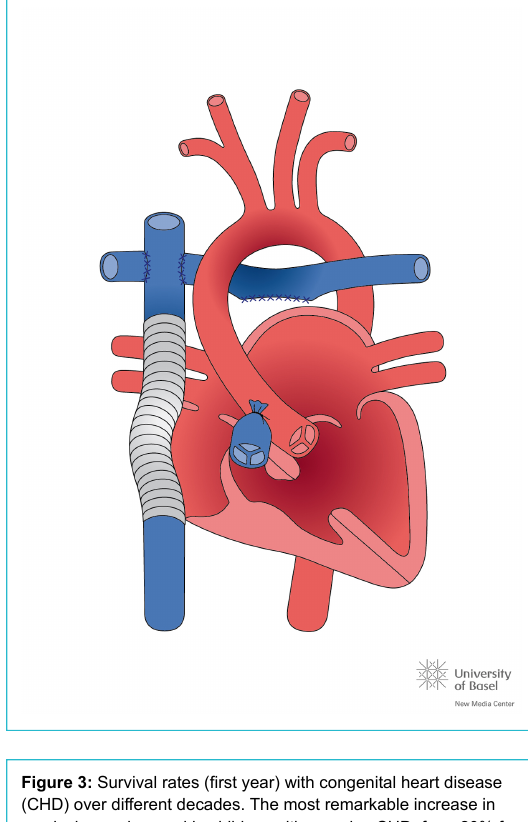
Figure 2: Fontan physiology. Modern type of Fontan procedure (total cavopulmonary anastomosis with an extracardiac conduit) for palliation of univentricular physiology, i.e. tricuspid atresia. De- routing of systemic venous return directly to the pulmonary artery avoids mixing of de-oxygenated and oxygenated blood in the func- tional single ventricle, and unloads the heart. The original concept was introduced by Fontan in 1971.Illustration taken from http://www.chd-diagrams.com. Creative Commons License Illustra- tions are licensed under Creative Commons Attribution-NonCom- mercial-NoDerivatives 4.0 International License by the New Media Center of the University of Basel.